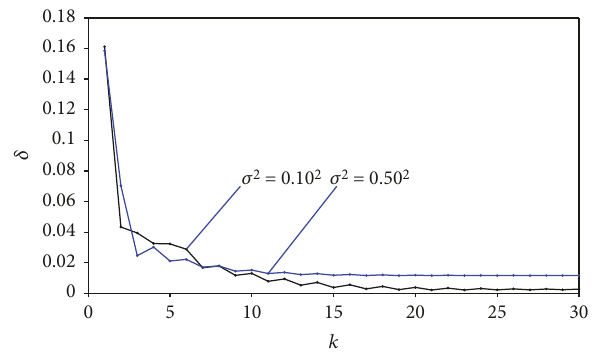
Figure 2: The parameter estimation errors δ versus k (KT-NI).